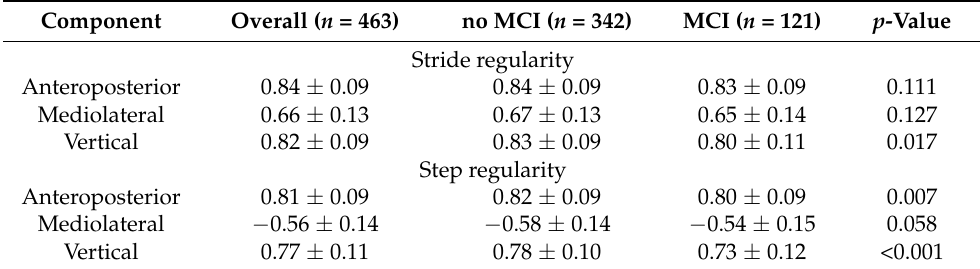
Table 2. Characteristics of gait